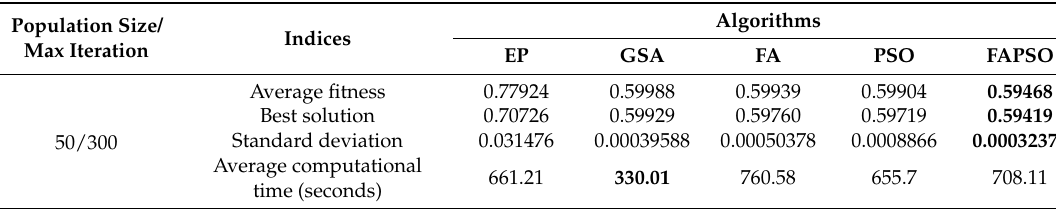
Table 6. Comparison of mean fitness value, best solution, standard deviation and average computational time for 100 runs on load shedding scheme.